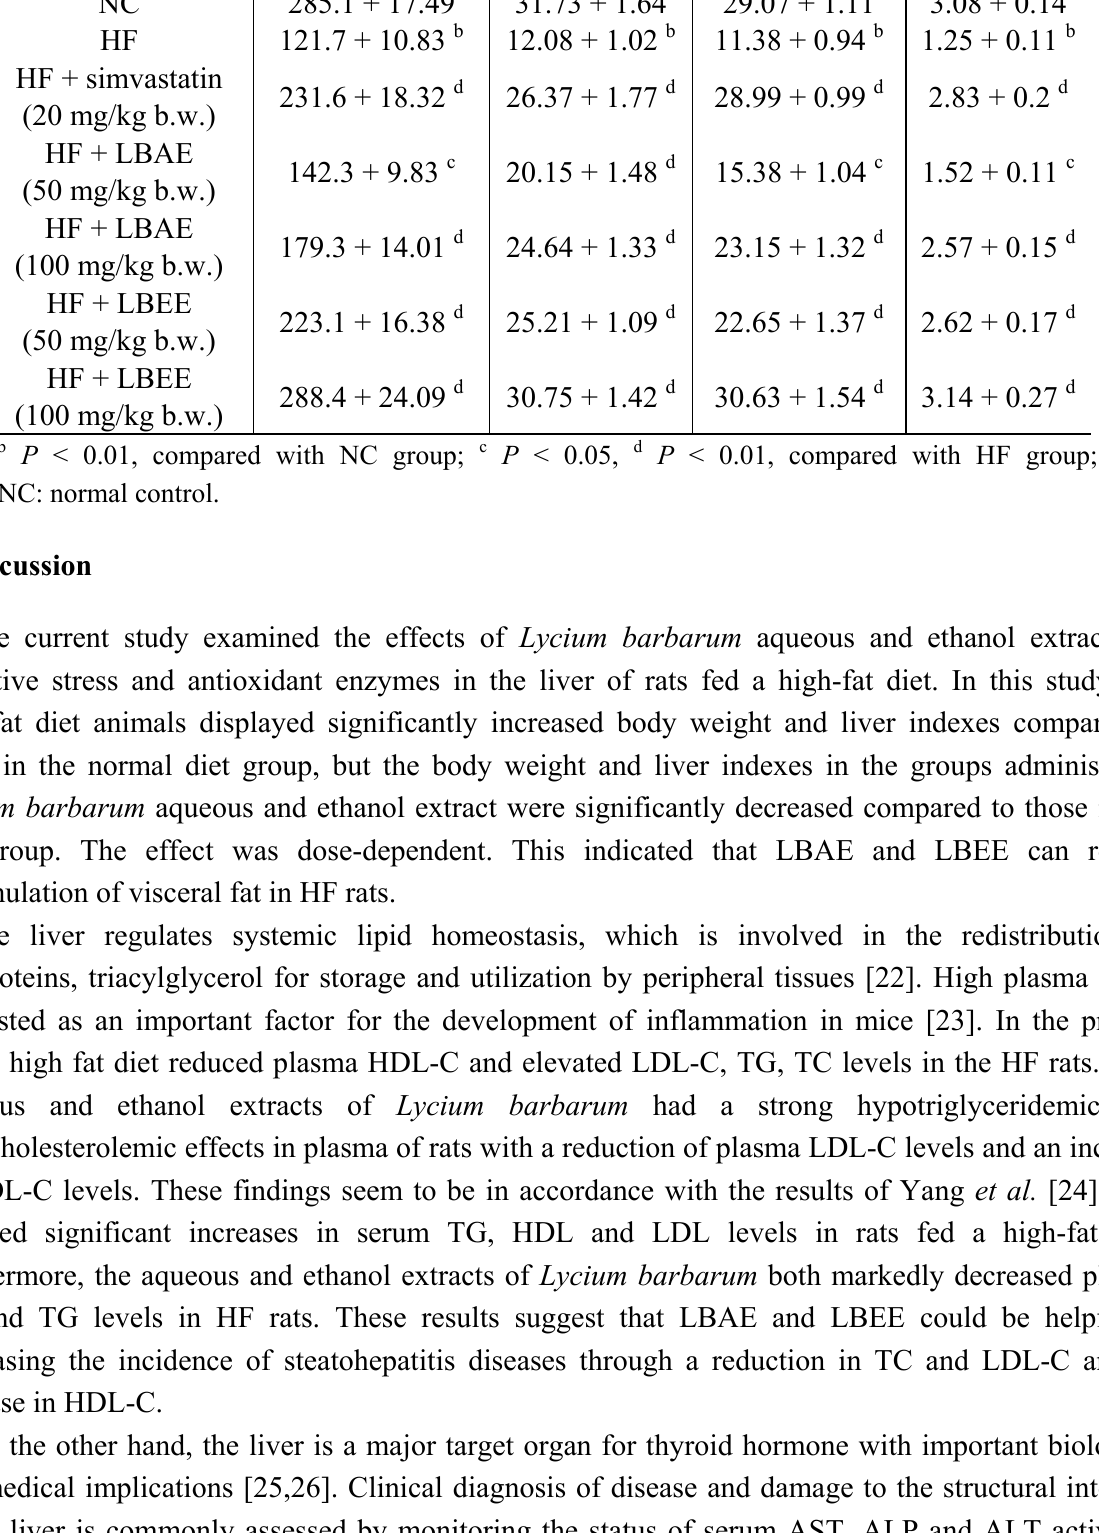
Table 5. Effect of LBAE and LBEE on liver SOD, CAT, GSH-Px and TAOC activities in rats. SOD CAT Group (U/mg prot.) (U/mg prot.) (U/mg prot.) NC HF + simvastatin (20 mg/kg b.w.) HF + LBAE (50 mg/kg b.w.) (100 mg/kg b.w.) (50 mg/kg b.w.) (100 mg/kg